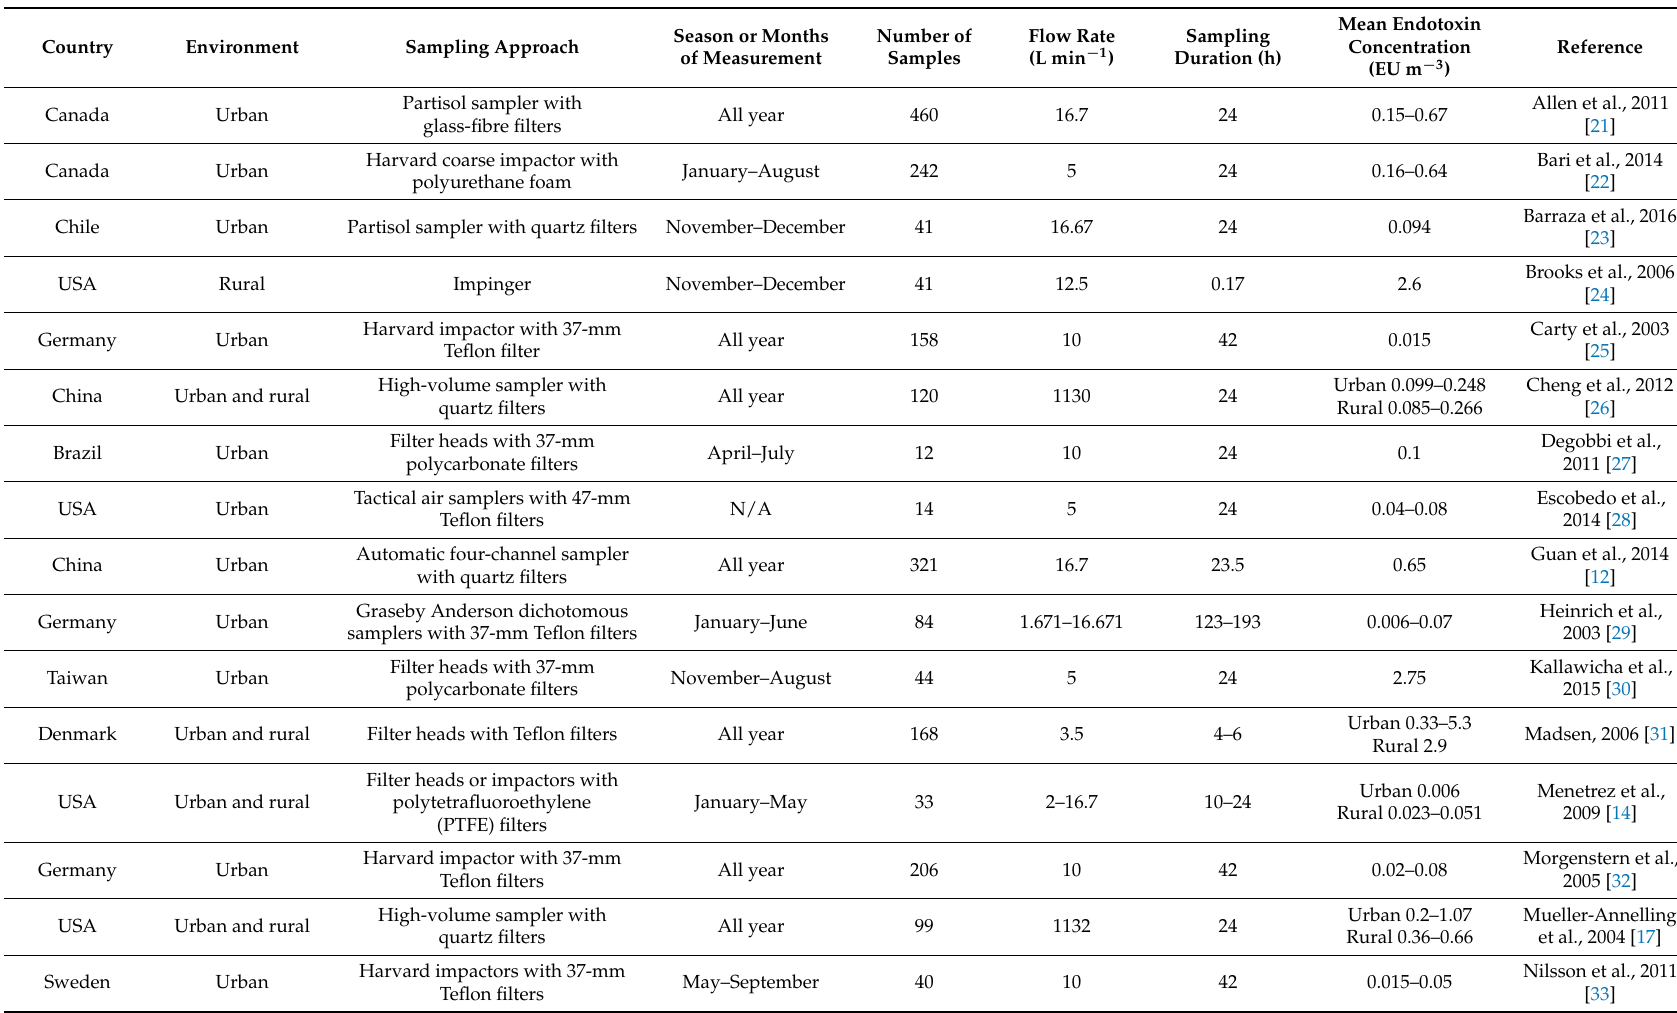
Table 1. Reported endotoxin concentrations in urban and rural air. EU—endotoxin units; USA—United States of America; N/A—not